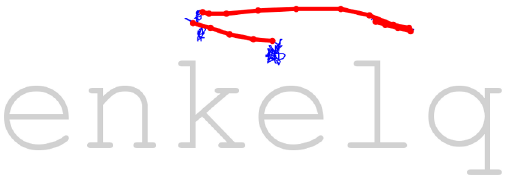
Figure 4. Plotted data from a single trial horizontally aligned with stimuli presented. Non-saccadic data points shown in blue, saccadic data points shown in red.